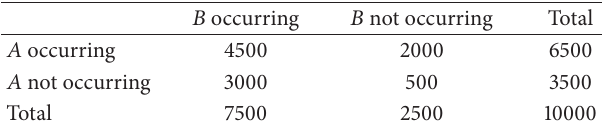
Table 2: The occurrence of “ 𝐴 ” and “ 𝐵 .” Table 3: The occurrence of “ 𝐴 󸀠 ” and “ 𝐵 󸀠 .”